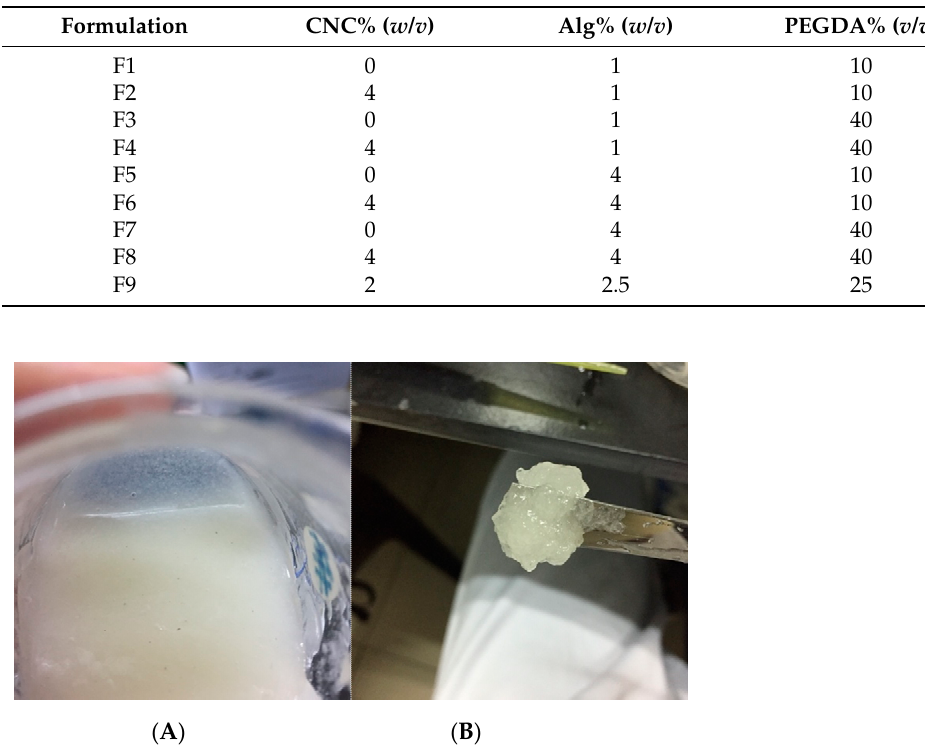
Table 1. CNC/Alg/PEGDA formulations.